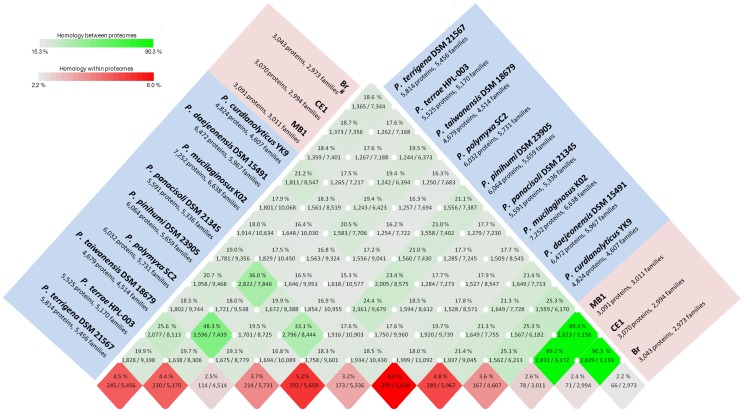
A BLAST matrix of an all against all protein comparison of 12 Paenibacillus genomes.